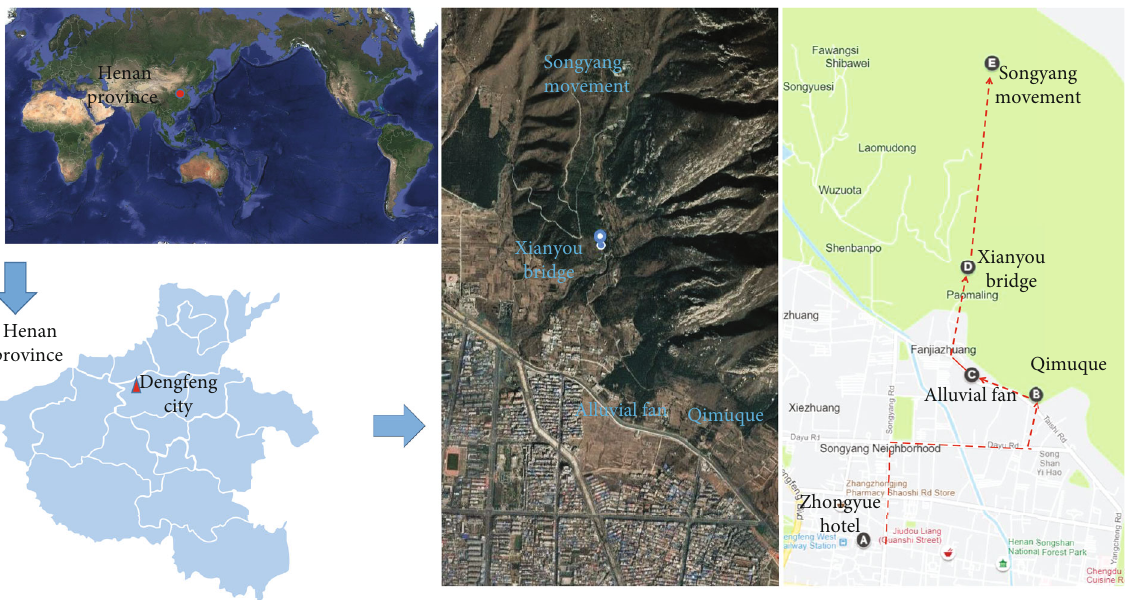
Figure 1: Location of the Junji peak practice route.